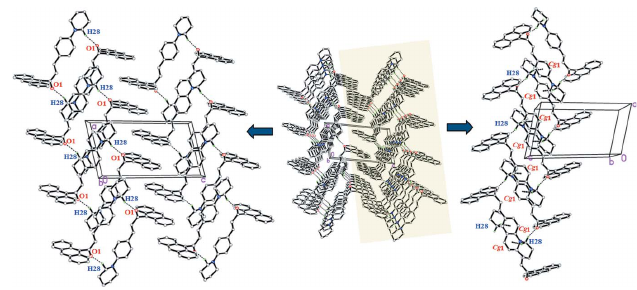
Figure 2 The crystal packing of (I) showing weak C—H (cid:2)(cid:2)(cid:2) O and C—H (cid:2)(cid:2)(cid:2) (cid:2) interactions.